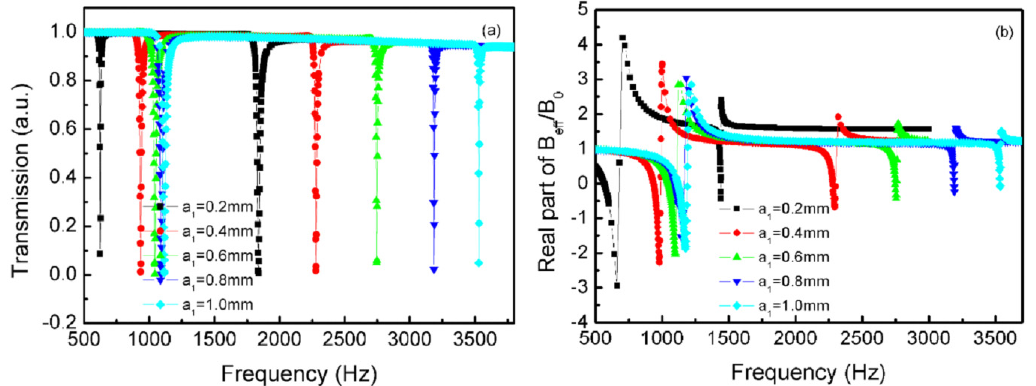
Figure 6. The curves of TLSHSs with various the inner hole diameters: ( a ) transmission and ( b ) effective modulus.